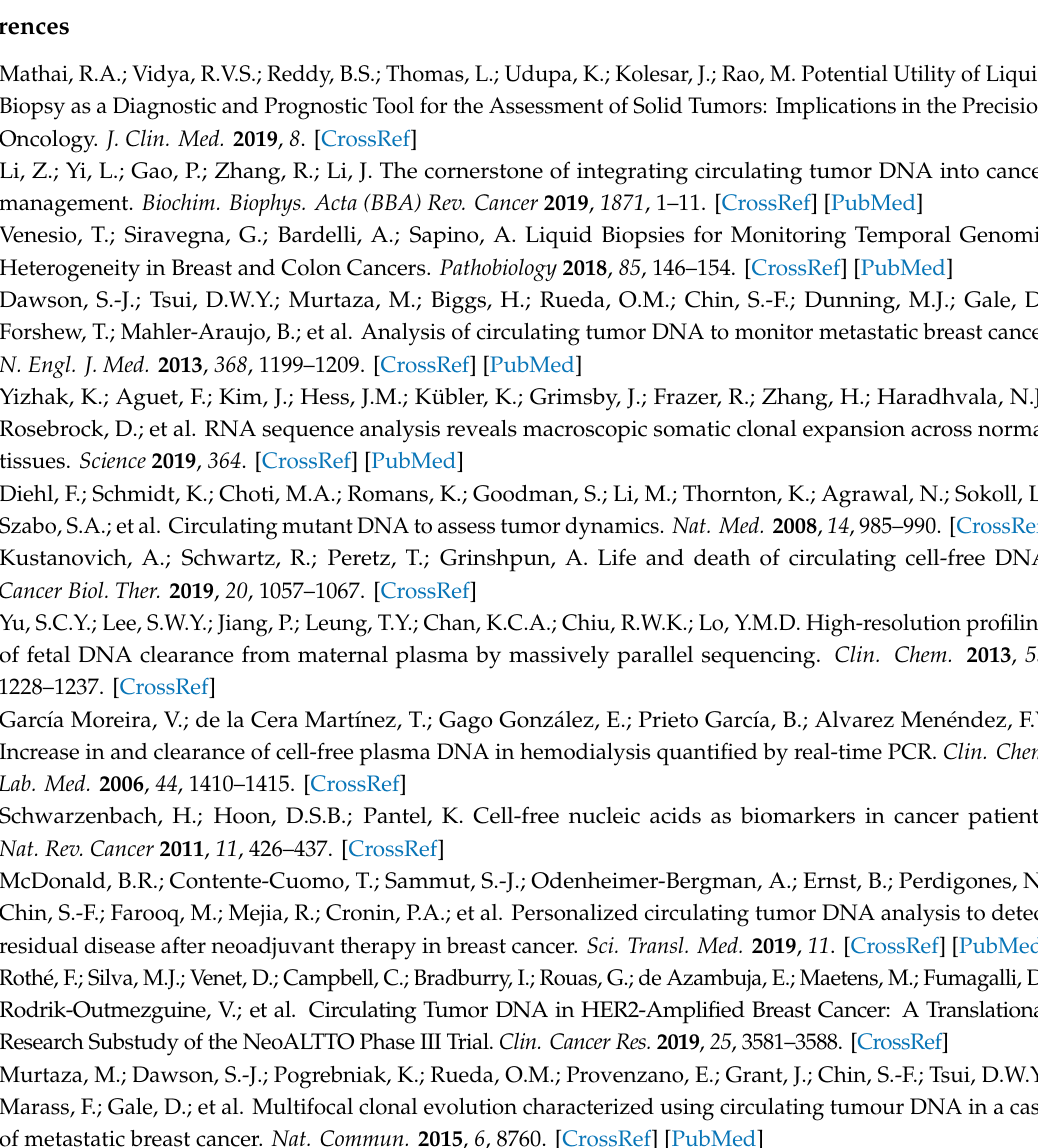
Supplementary Table S1 Parameters used for filtering of FFPE results, Supplementary Table S2. All changes discovered in FFPE samples after filtering, Supplementary Table S3. Fisher’s exact test results for presence of deleterious variants in genes, Supplementary Table S4. Genetic alterations and CNVs with repeated measurements during sample collection